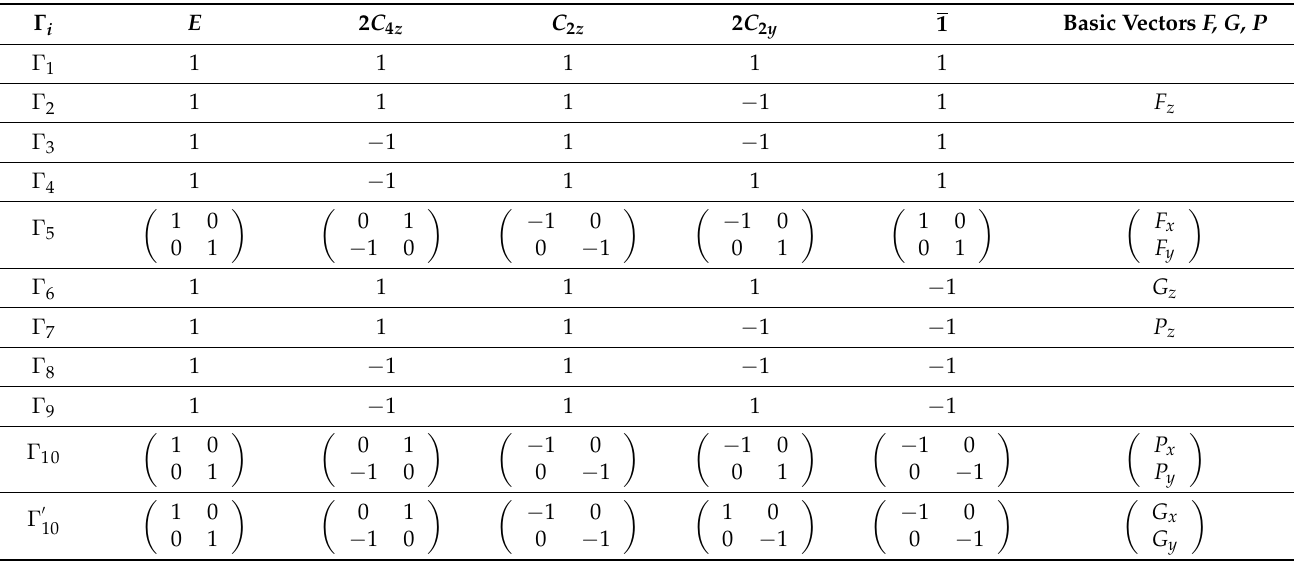
first line of Table 5 contains generators of the D 17 last column contains basic magnetic and ferroelectric functions. Table 5. Irreducible representations of the I 4/ mmm symmetry group and basic